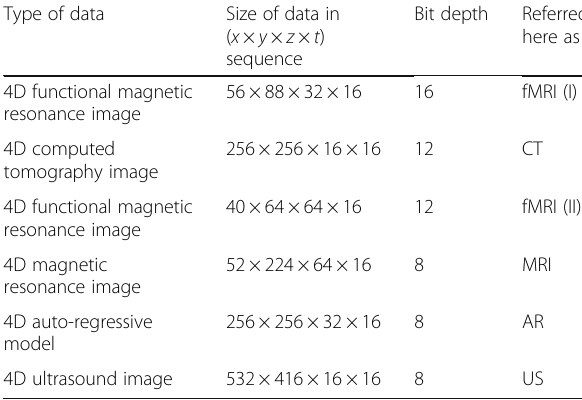
Table 2 Type of data used in the experiments Type of data